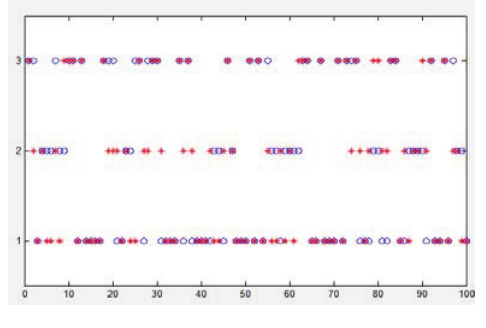
Fig.3 The prediction results of HMM